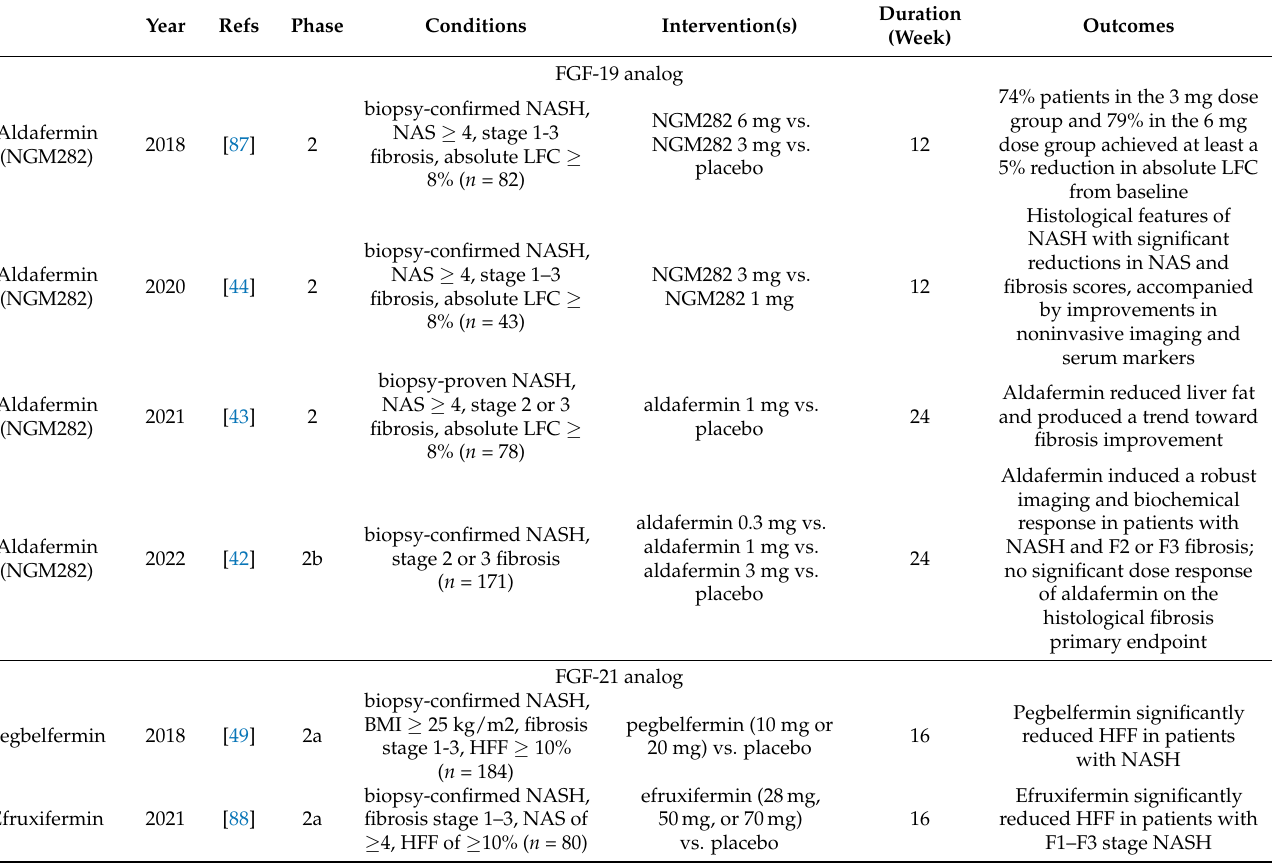
BMI: body mass index; FGF-19: fibroblast growth factor-19; FGF-21: fibroblast growth factor-21; HFF: hepatic fat fraction; LFC: liver fat content; NAS: NAFLD activity score; NASH: nonalcoholic